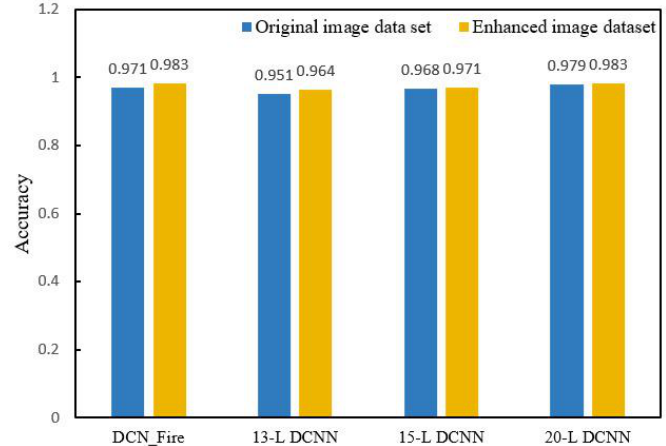
Figure 4. Flame image verification accuracy comparison of the DCN_Fire model with 13-layer, 15-layer, and 20-layer DCNN models.